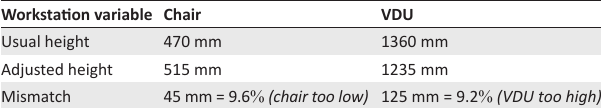
TABLE 3: Subject workstation